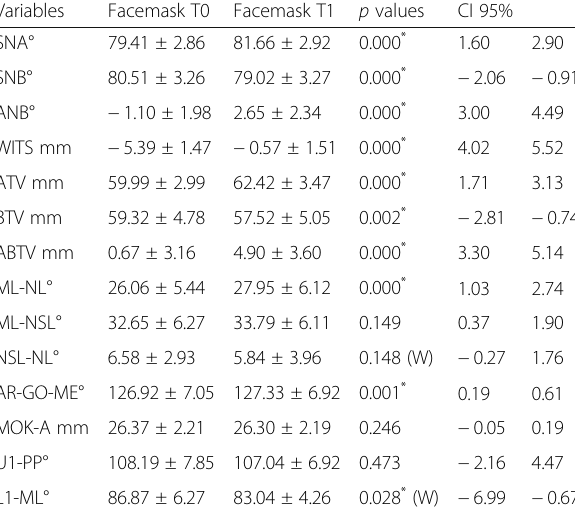
Table 3 Cephalometric values; comparison of initial values before treatment Variables